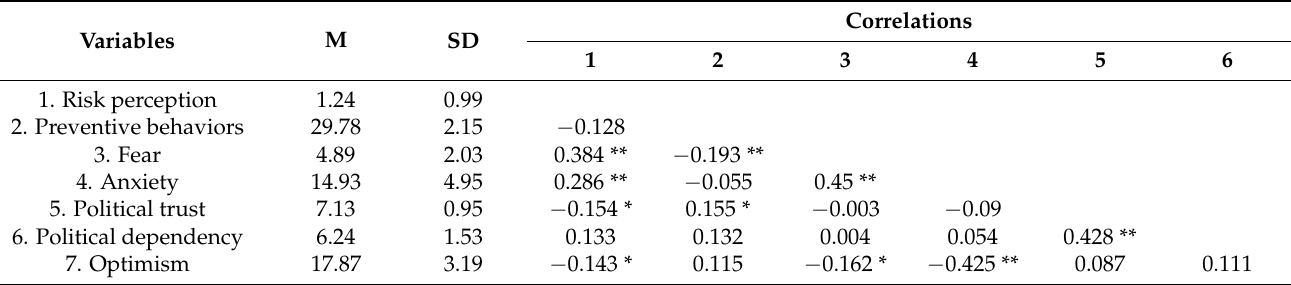
Table 1. Descriptive statistics and